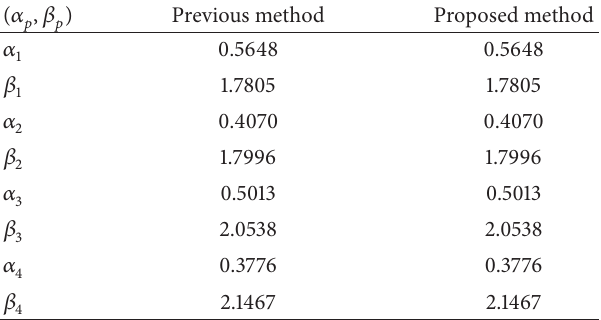
Table 2: The optimal polarization parameters got by two methods (rad).